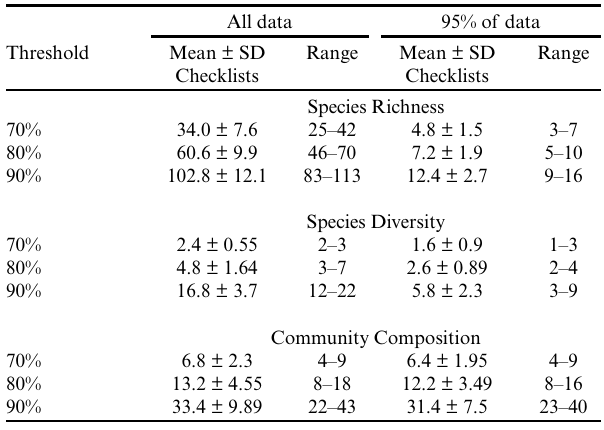
Table 3 . The minimum number of checklists (2010–2016), necessary to meet 70%, 80%, and 90% thresholds for five global greenspaces (Table A1.2) that were compared to the North American analysis. Results are shown for species richness, species diversity, and community composition (Bray-Curtis similarity). Separate analyses are provided for the full dataset, and for those species recorded on > 5% of all checklists at the site.